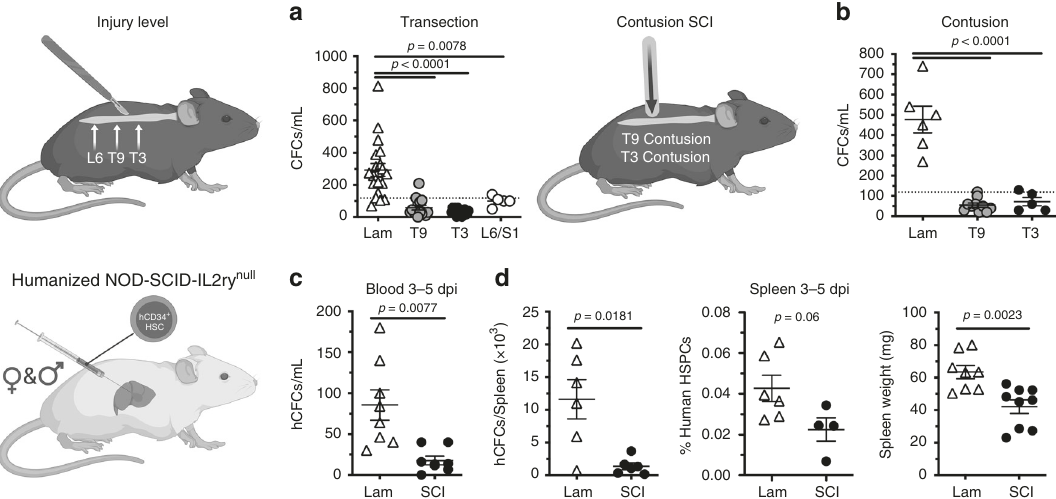
Fig. 4 Complete and incomplete SCI impairs acute mouse and human HSPC mobilization. a Number of CFCs per mL whole blood after T3, T9, or L6/S1 transection injury. b Number of CFCs per mL whole blood after T3 and T9 contusion injury. c Number of hCFCs per mL whole blood. d Total numbers of splenic hCFCs, proportion of splenic hCD34 hi /hCD38 low human HSPCs, and spleen weight of hNSG mice 3 – 5 dpi. All data are mean ± SEM, one-way ANOVA with Tukey multiple comparison test ( a , b ), two-sample t -test ( c , d ); n = 20, 15, 14, and 5/group in a ; n = 6, 10, and 5/group in b ; n = 8/group in c ; n = 6, 6; 6, 4; 8 and 9/group in d . dpi days post-injury, Lam laminectomy (sham injury). Source data are provided as a Source Data fi